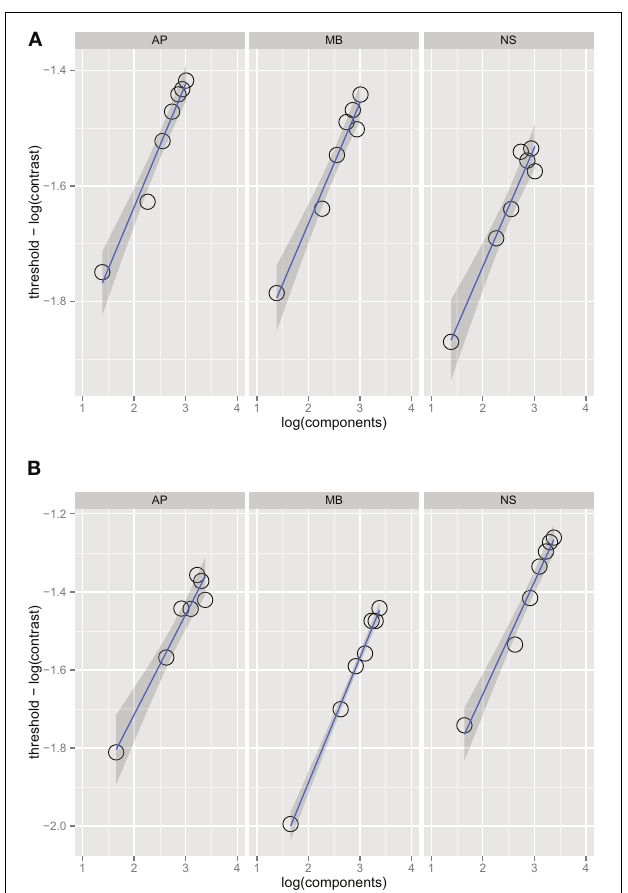
FIGURE 1 | Noise detection thresholds versus stimulus bandwidth expressed in number of spatial frequency components in the stimulus for three observers in Experiment 1 in the one octave (A) and two octave (B) spatial frequency conditions. The blue lines are weighted maximum likelihood fits to the data and the shaded region the 95% confidence interval for the fit. The fits did not include the data from the narrowest bandwidth